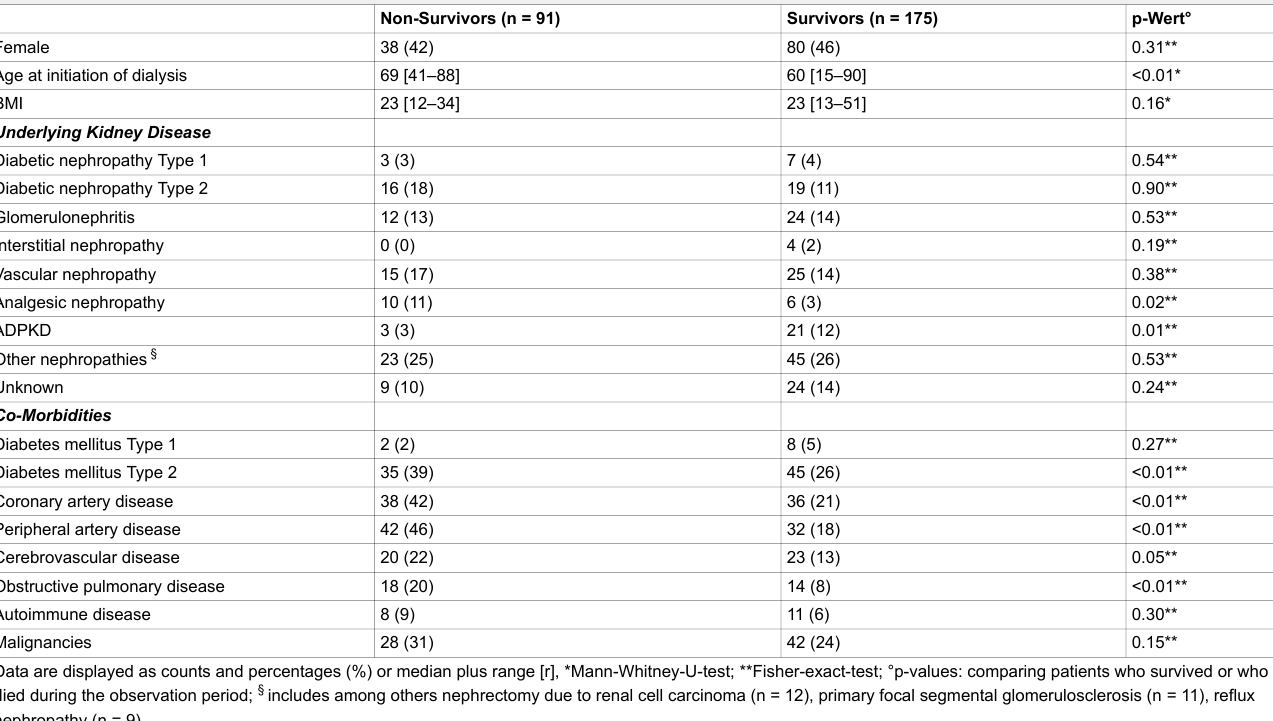
Table 6: Characteristics of 23 patients withdrawing haemodialysis: Age at death,